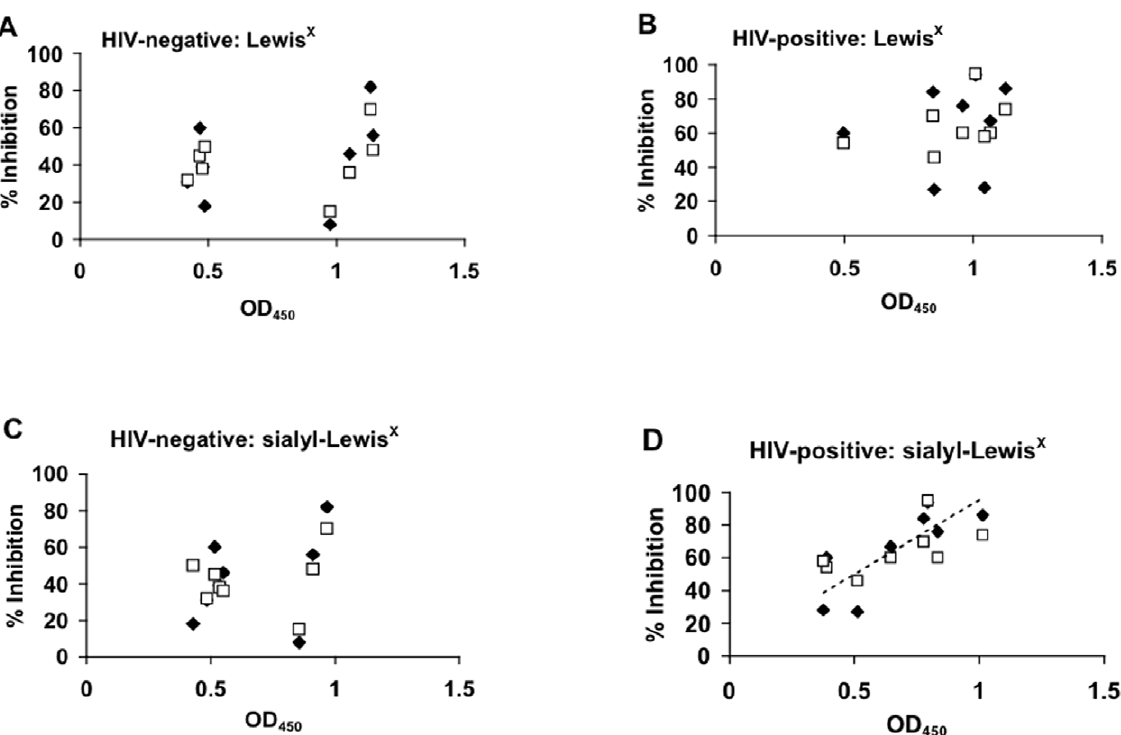
Figure 3. Lewis X and sialyl-Lewis X in breast milk. Levels of Lewis X and sialyl-Lewis X were measured by ELISA in breast milk samples from both HIV-positive and HIV-negative donors. The results were then compared to cell-free HIV-inhibitory activity for the same samples. Data is expressed as the percent inhibition of cell-free R5 ( % ) and X4 ( ¤ ) HIV-1 relative to the levels of either Lewis X or sialyl-Lewis X measured for each sample.